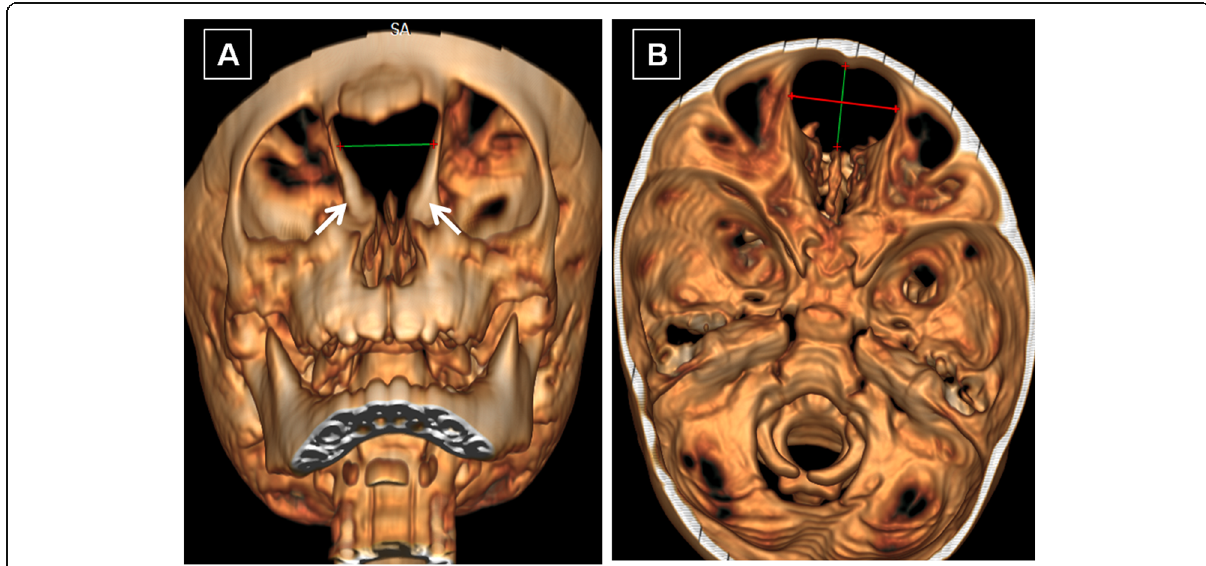
Fig. 12 CT scan with volume rendered technique. ( a ) represents defect seen from below and ( b ) represents defect seen from above. CT scan with volume rendered technique shows presence of large anterior skull base defect in midline marked by calipers with widely separated and deformed crista galli shown by white arrows shown in ( a